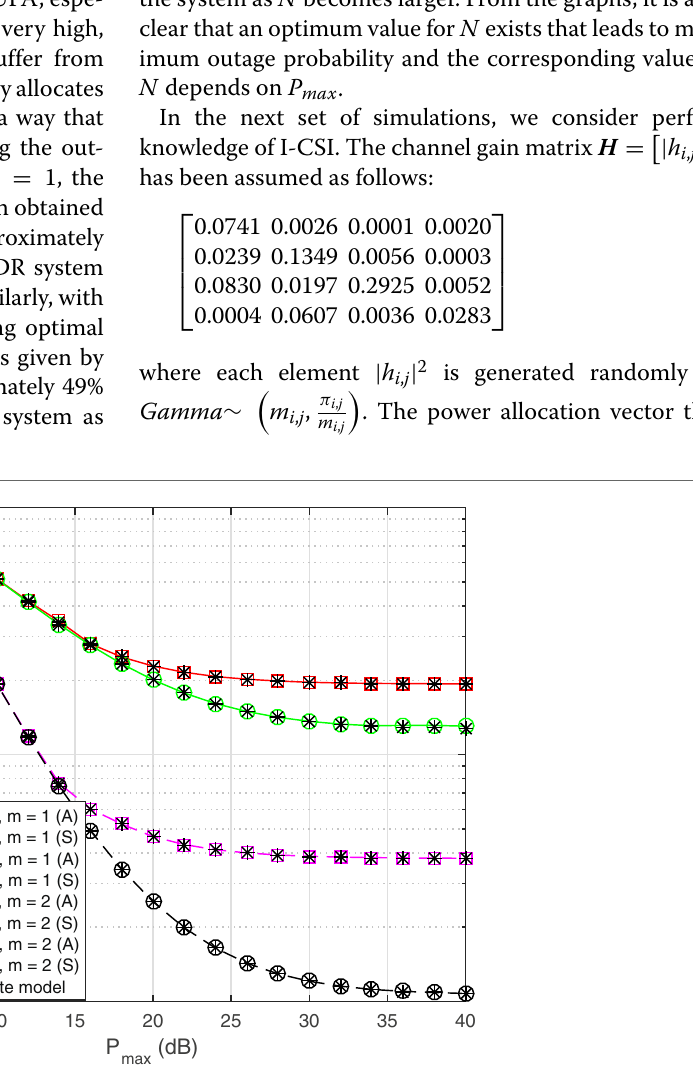
Fig. 3 Outage probability performance of four-hop FDR system vs P max under UPA and OPA, for different values of m : π 0 =